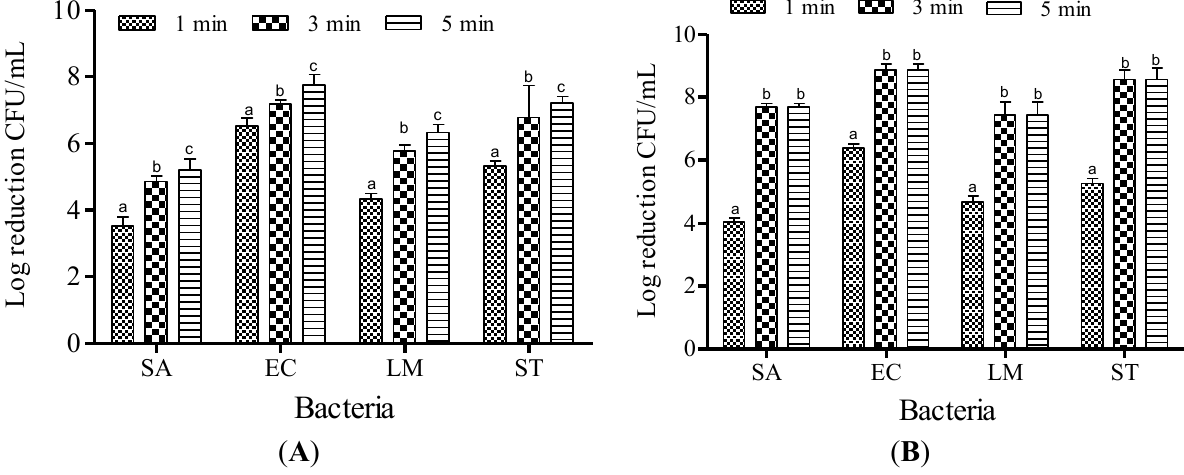
Figure 5. Inactivation of different foodborne pathogens treated with slightly acid low concentration electrolyzed water at 10 ppm ( A ) and 20 ppm ( B ) at 40 °C for different dipping times. Vertical bars represent means of three replications ± standard deviation. Bars labeled with different letters indicate significant differences at p < 0.05. SA: S. aureus , EC: E. coli O157:H7, LM: L. monocytogenes , ST: S. Typhimurium . The initial level of each foodborne pathogen was 8.86, 7.68, 7.43, and 8.56 for EC, SA, LM, and ST,